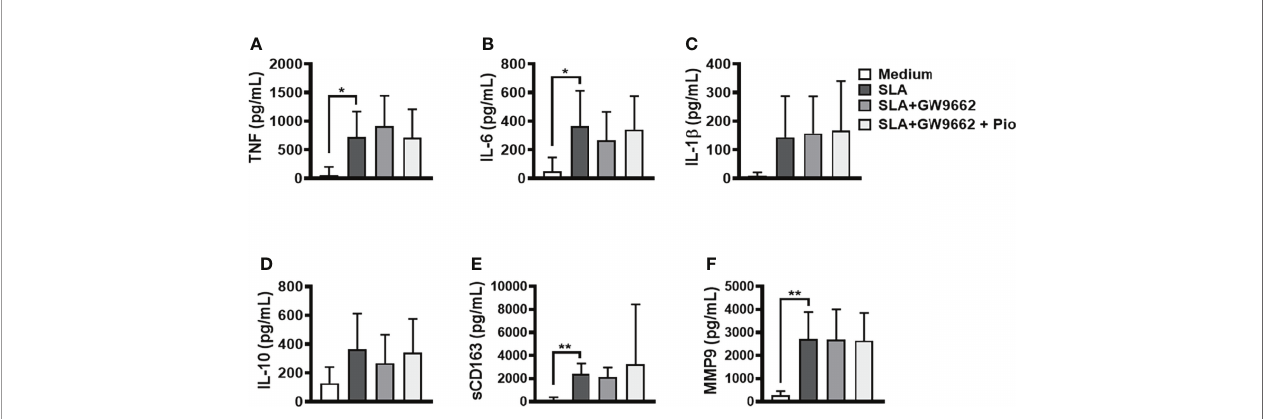
FIGURE 4 | Blockage of peroxisome proliferator-activated receptor- g (PPAR- g ) abrogates pioglitazone-mediated downregulation of in fl ammatory mediators induced by SLA . Peripheral blood mononuclear cells (PBMCs) from cutaneous leishmaniasis (CL) (n = 11) were cultured in the presence of GW9662 (10 m M) for 1 h and next stimulated with soluble Leishmania antigen (SLA) (5 m g/ml) or pioglitazone (1 m M) for 24 h. The levels of (A) TNF, (B) IL-6, (C) IL-1 b , (D) IL-10, (E) sCD163 and (F) MMP9, were quanti fi ed by the ELISA technique. The box represents the mean, and the line above the box is the SD. Statistical analyses were performed using the ANOVA